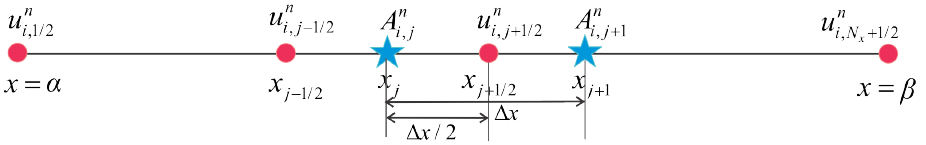
and u n , for i = i , j i , j + 1/2